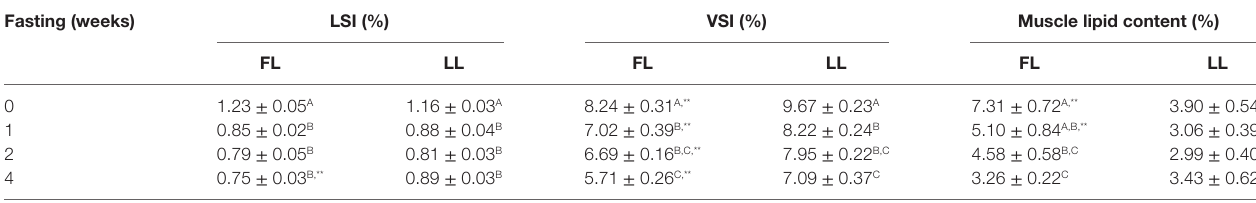
TaBle 3 | Energy-related physical characteristics of fat line (FL) and lean line (LL) rainbow trout of experiment II under normal feeding conditions (0-week fasting), and after 1, 2, and 4 weeks of fasting. Fasting (weeks) lsi (%) Vsi (%) Muscle lipid content (%) Fl ll